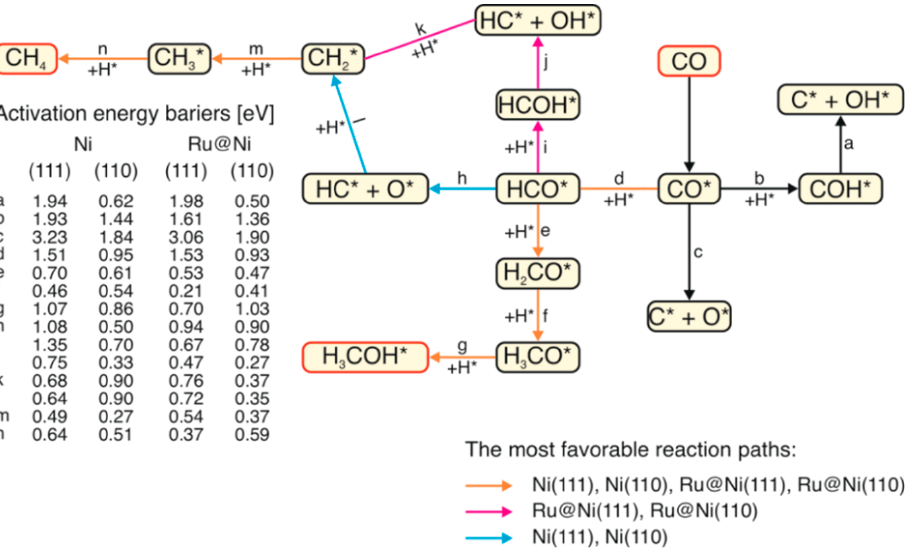
Figure 5. Scheme for the formation of methane and methanol from CO and H 2 on Ni (111), Ni (110), Ru@Ni (111) and Ru@Ni (110) surfaces, where asterisk indicates chemisorbed species. According to [104].